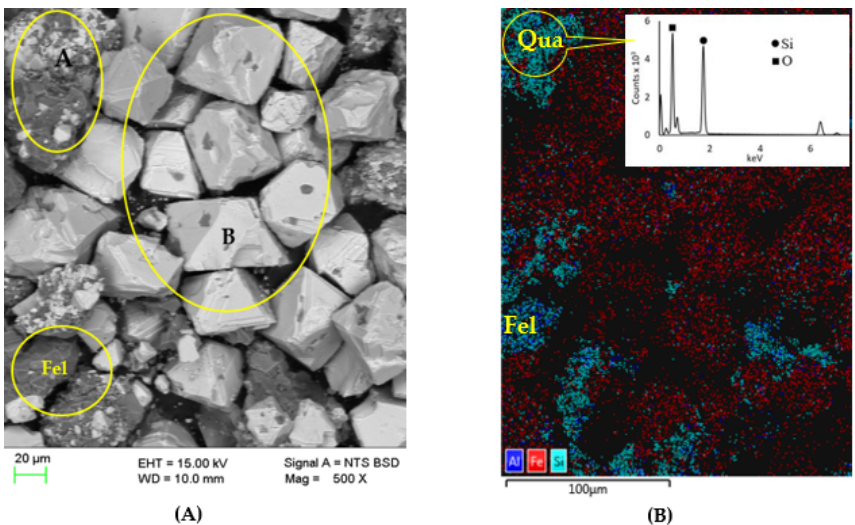
Figure 9. SEM BSE ( A ) and chemical map ( B ) images of a portion of the concentrate. Fel = felspar; Qua = quartz; A = magnetite in close association with quartz; B = liberated magnetite.